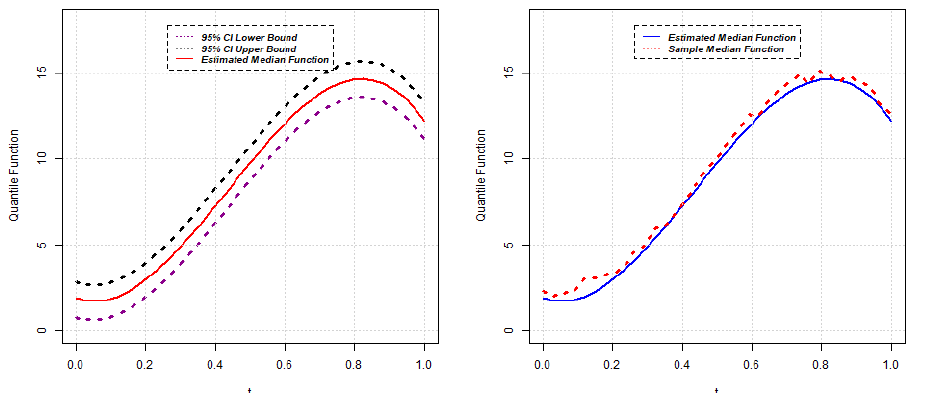
Figure 8. Estimated median function and C.I. ( left ); Estimated median and sample median ( right ) for Model 3.